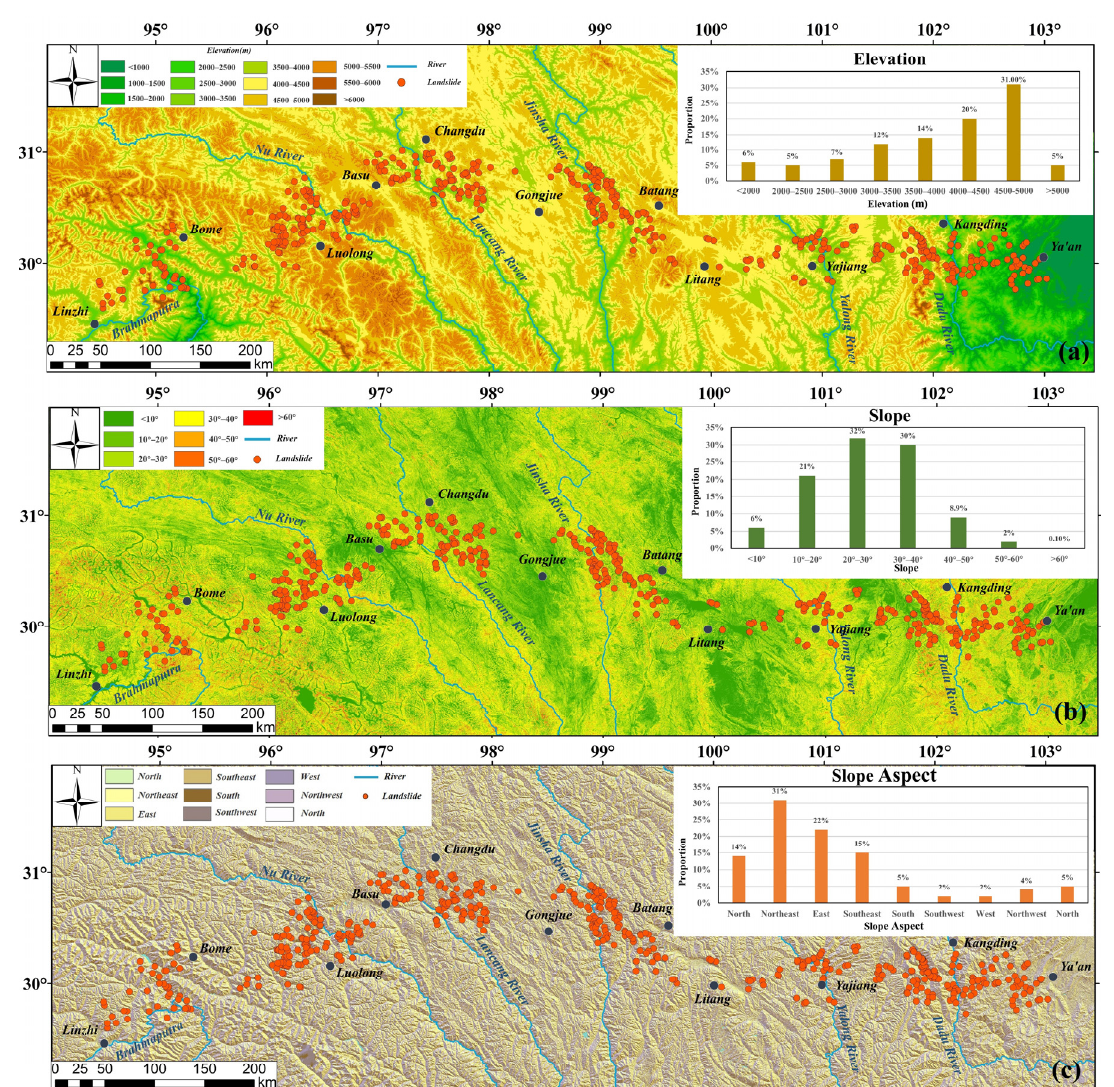
Figure 11. Relationships between vertical geological factors and landslides. Relationships between ( a ) elevation and spatial landslide distribution; ( b ) slope and spatial landslide distribution; and ( c ) aspect and spatial landslide distribution. The statistical charts of each factor are displayed in the upper-right corner in each map.